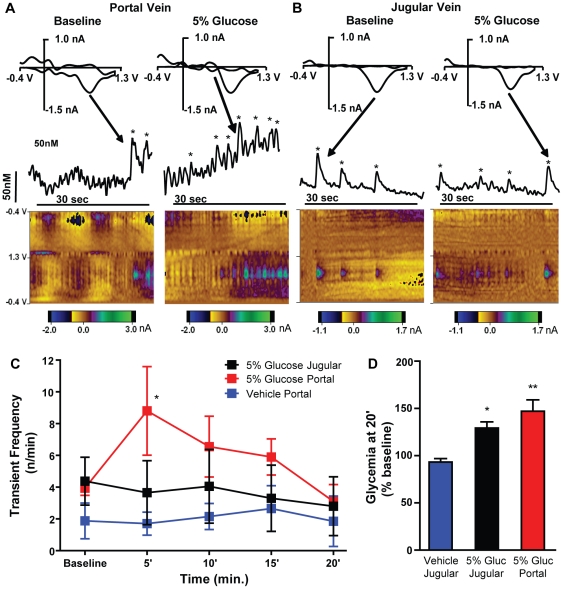
Nucleus accumbens dopamine transient frequency increases after injection of glucose in the hepatic-portal vein.Fast-scan cyclic voltammetry was used to identify spontaneous dopamine release events (transients) in the nucleus accumbens shell of anesthetized rats. Measurements were conducted for a baseline period, and also during and after infusion of 5% glucose in the JV (n = 4) or HPV (n = 4), or vehicle in the latter (n = 4). A. This panel shows example measurements in one animal before (figures on the left) and after (figures on the right) onset of 5% glucose infusion in the HPV. The two dimensional color plots at the bottom of the panel show the voltammetric current (encoded in color, nA) plotted against the applied potential on the Y axis (V) and the acquisition time on the X axis (sec.). The green spots at 0.62 V (the peak oxidation potential for dopamine) in the lower half of the plots represent dopamine oxidation at the surface of the carbon-fiber microelectrode. The current at the peak dopamine oxidation potentials was converted to dopamine concentration following post-calibration (see Methods) and is displayed above the color plots, approximately aligned with them in time. The panels near the top of the figure are cyclic voltammograms of the peaks indicated by arrows that were obtained by subtracting baseline voltammograms just prior to onset of the transient. Dopamine transients were considered as such when they had voltammograms that were significantly correlated (r>0.86) with those of a dopamine template elicited previously by electrical stimulation of the ventral tegmental area. The peaks that were thus classified as dopamine are indicated by asterisks. B. This panel shows an example measurement as was described above (A) but for JV, rather than HPV administration of 5% glucose. Note that the evoked activity is much less. C. Here we show dopamine transient frequency prior to infusion in each of the three groups (baseline) and in 5 min bins following infusion onset. Data were analyzed using two-way repeated measures ANOVA (see text) and post-hoc analysis indicated that, when compared to the respective time period for HPV vehicle administration, transient frequency in the HPV glucose group was significantly higher in the first 5 minutes after infusion onset (t = 3.1, p<0.05) but not in the remaining time periods (t<1.9, p>0.05 for all), or at any point in the JV glucose group (t<1.1, p>0.05 for all; post-hoc Bonferroni t-tests). D. In the same rats, tail blood glycemia was also measured prior to and 20 minutes after infusion of 5% glucose in the JV (n = 3) or HPV (n = 3), or vehicle in the latter (n = 4). No differences for absolute glycemia (mg/dL) were found between groups at baseline (PV vehicle - 157±7, JV 5% glucose - 169±22, HPV 5% glucose - 135±14; F = 1.4, p = 0.31, repeated-measures one-way ANOVA; t<1.7, p>0.05 for all pair-wise comparisons, post-hoc Bonferroni t-tests; data not shown in figure). However, as expected, an overall significant difference was found for relative glycemia (% baseline) at 20′ (F = 14.6, p = 0.0032, repeated-measures one-way ANOVA), with significant differences between glycemia after HPV vehicle (93±4) and that after JV 5% glucose (129±6; t = 3.5, p<0.05) and HPV 5% glucose (147±12; t = 5.2, p<0.01). Importantly, no differences were found between values after each of the two glucose stimuli (t = 1.6, p>0.05, post-hoc Bonferroni t-tests). *p<0.05, **p<0.001.